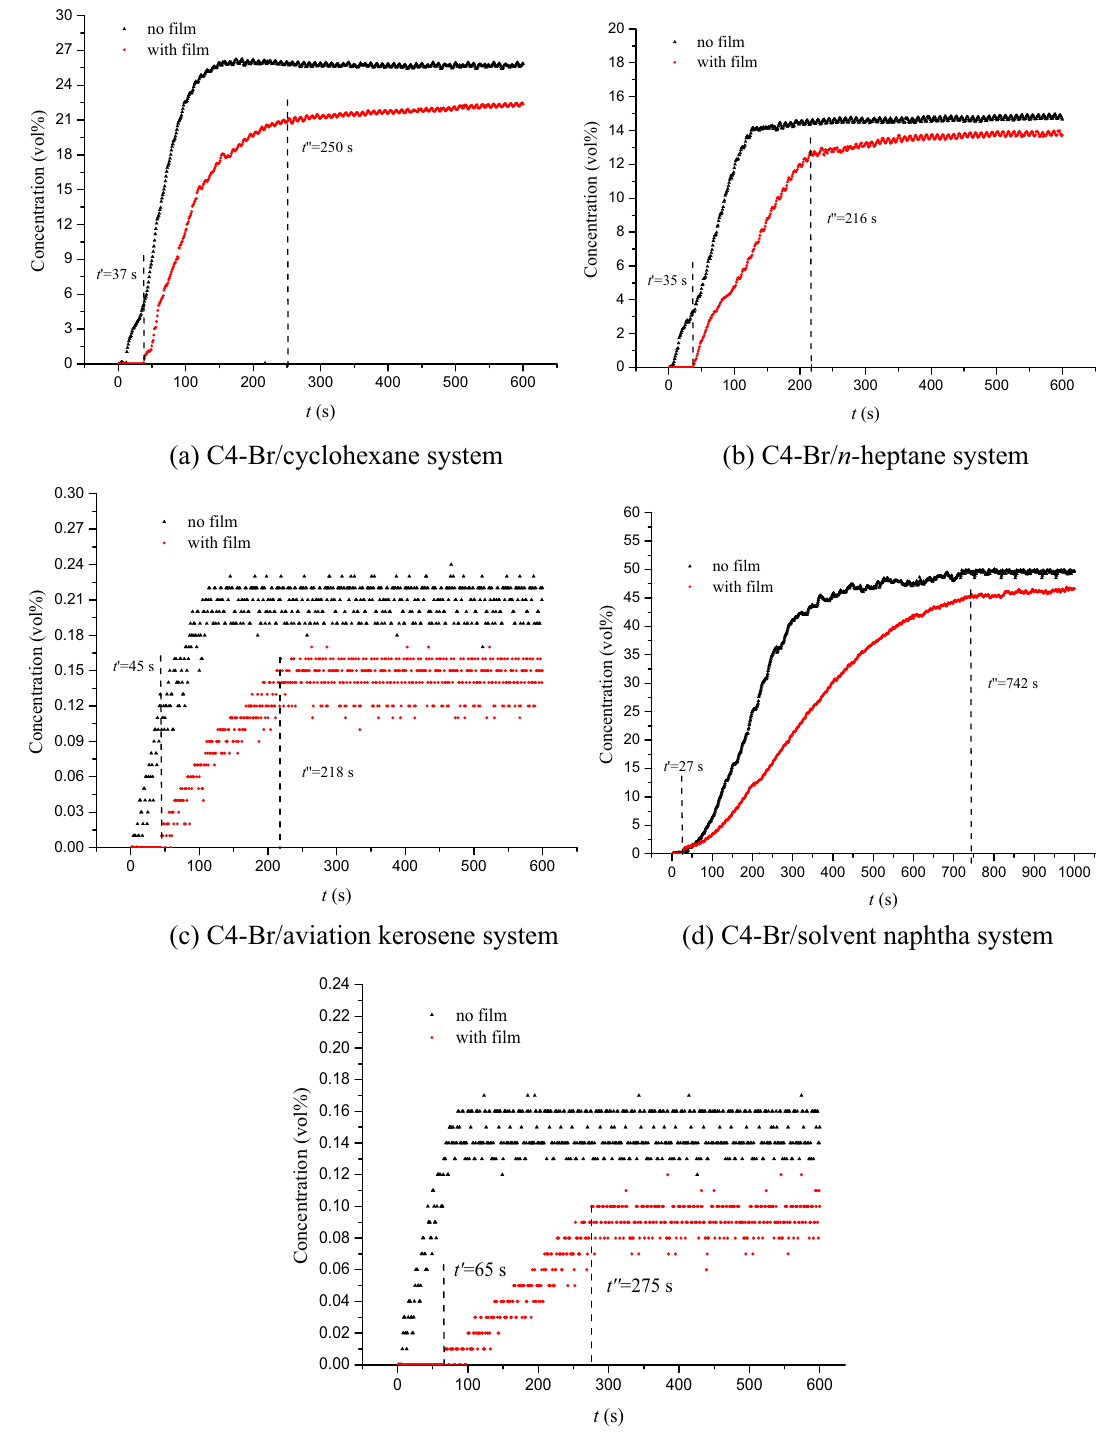
Figure 6. The volume concentration of the fuel vs. time with and without sealing by aqueous film at 25 °C: t’ was the absolute sealing time and t ” was the loss sealing